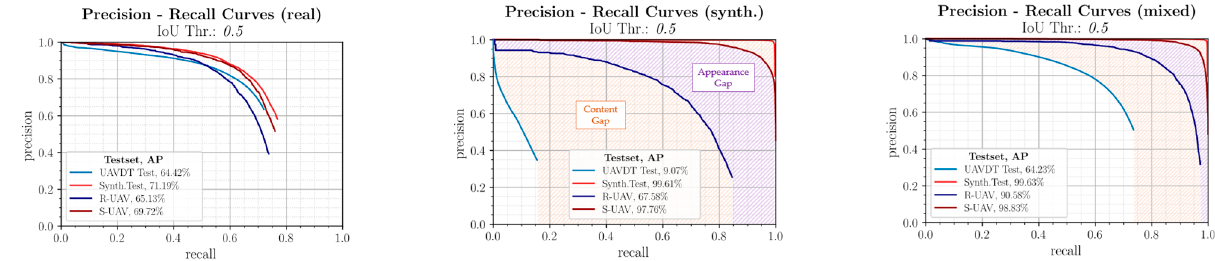
Figure 11. PR curves comparing detection performance for the different training configurations for an IoU threshold of 0.5.